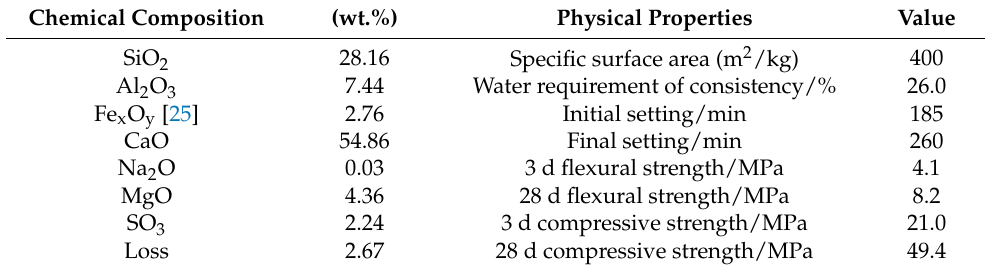
Table 1. Physical and chemical properties of cement. Chemical